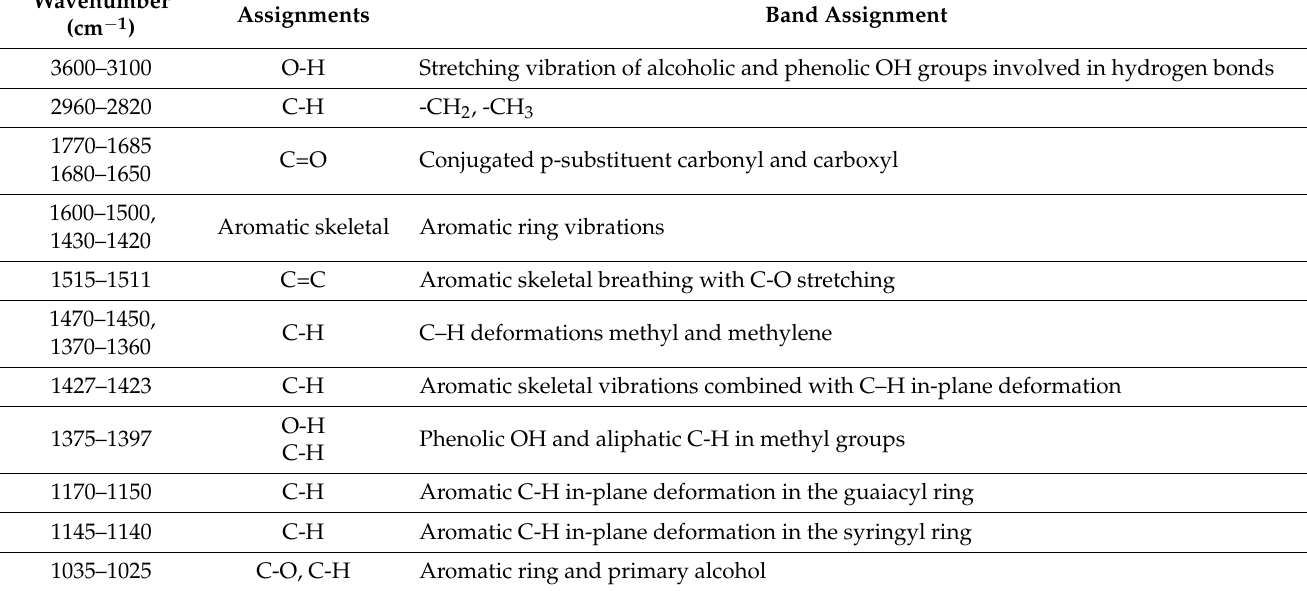
Table 5. Assignment of functional groups to FTIR spectrum wavenumbers